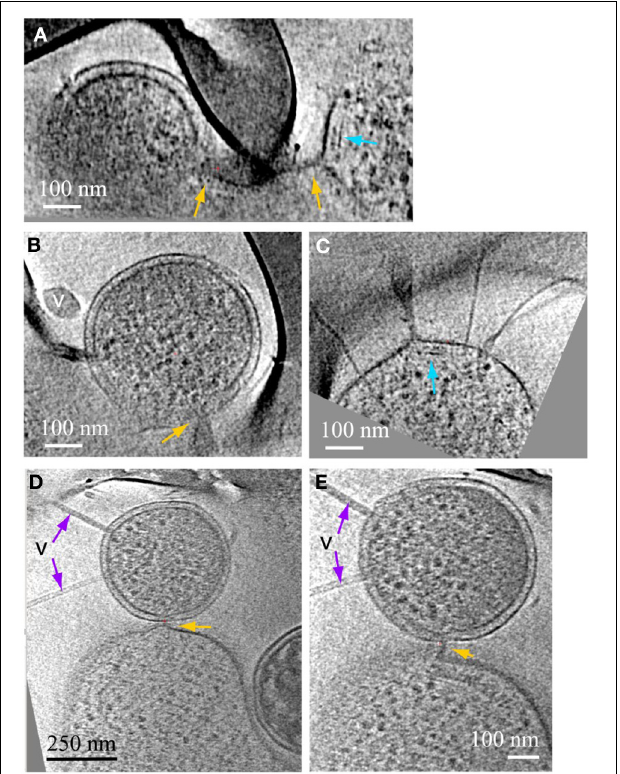
FIGURE 5 | ARMAN— Thermoplasmatales inter-species associations and viral infection processes. Slices from a 3D cryo-ET reconstruction. (A–C) are computational slices at different orientations through an ARMAN and a Thermoplasmatales lineage archaea cell connected through a cytoplasmic bridge. In (A) the cytoplasmic bridge is directly under a grid bar with ARMAN to the left and the plasma cell to the right respectively. The blue arrow points to a band, within the cytoplasmic space, adjacent to the connection. (B) The ARMAN cell in (A) ; the yellow arrow points to the cytoplasmic side of the connection; the ARMAN cell is infected by a virus (v) of a different morphotype than in Figure 4 . (C) The Thermoplasmatales lineage cell in (A) ; the putative flagella indicates the plasma cell is either (A or E) ; for instance, see above and to the right of the feature indicated with the blue arrow. (D,E) Are slices through a different type of ARMAN (top)- Thermoplasmatal (bottom) lineage archaea association. The ARMAN cell, top, is infected by rod-shape viruses (v) indicated by purple arrows and the connection (yellow arrow) is a short and thick line of